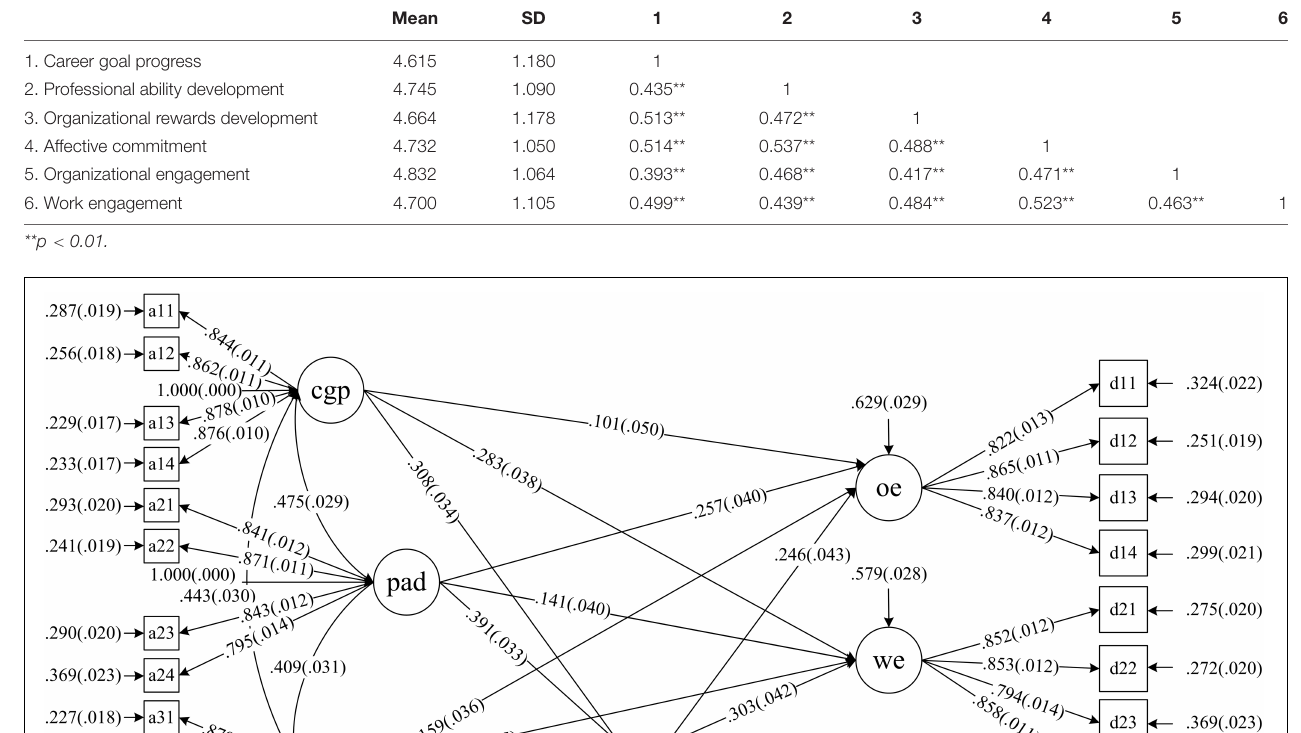
TABLE 1 | Statistical test and correlation test.